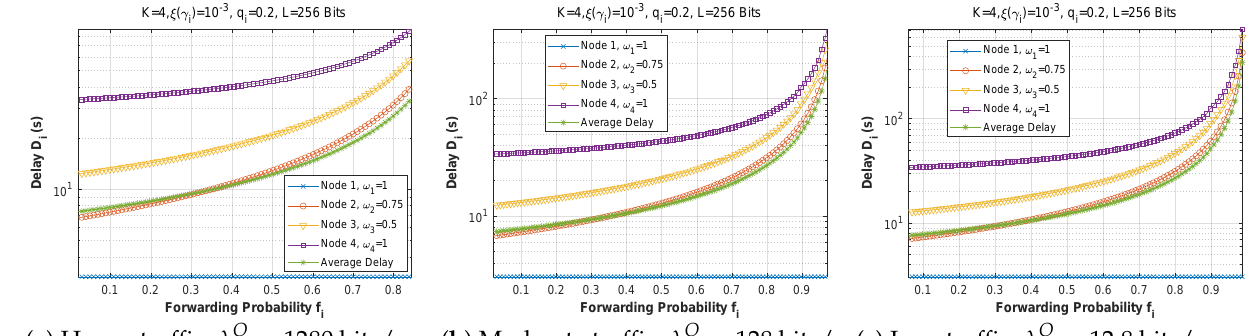
Figure 10. Setting 2: The delay experienced at each mobile device when varying the forwarding probability with the arrival rate λ Q . i